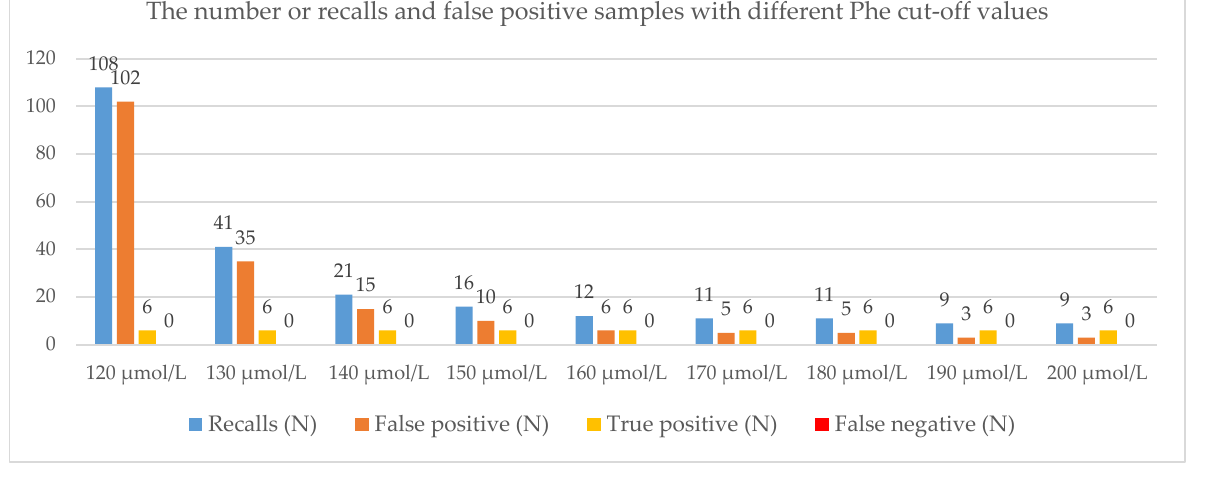
Figure 2. The number of recalls, false positives, true positives, and false negatives at different cut-off values; number of samples: 37.784, number of true positives: 6. Table 2. Specificity, sensitivity, positive and negative predictive value, and detection rate at different Phe cut-offs.